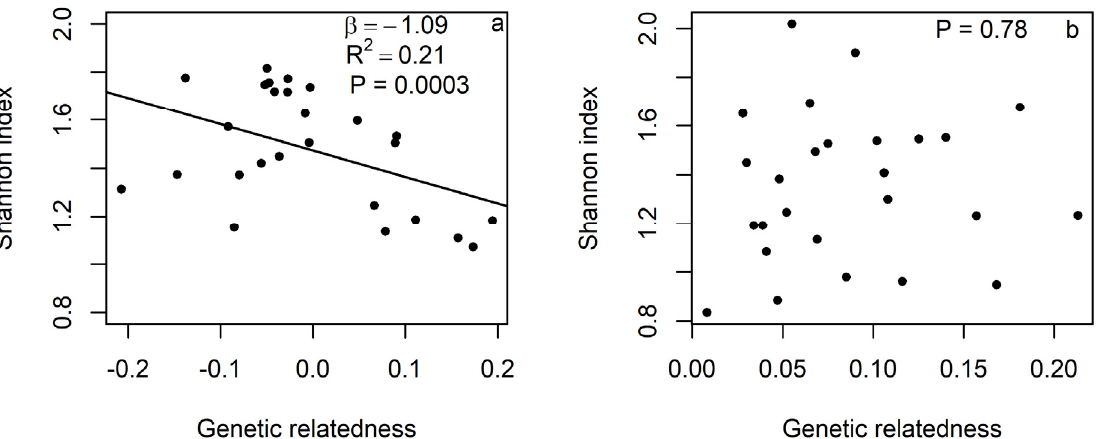
Figure 1. Relationships between the genetic relatedness (Queller and Goodnight coefficients) and genetic diversity (Shannon diversity index) of ( a ) Daurian pikas and ( b ) Mongolian gerbils in Inner Mongolia, China. The letter β is the estimate of regression slope.